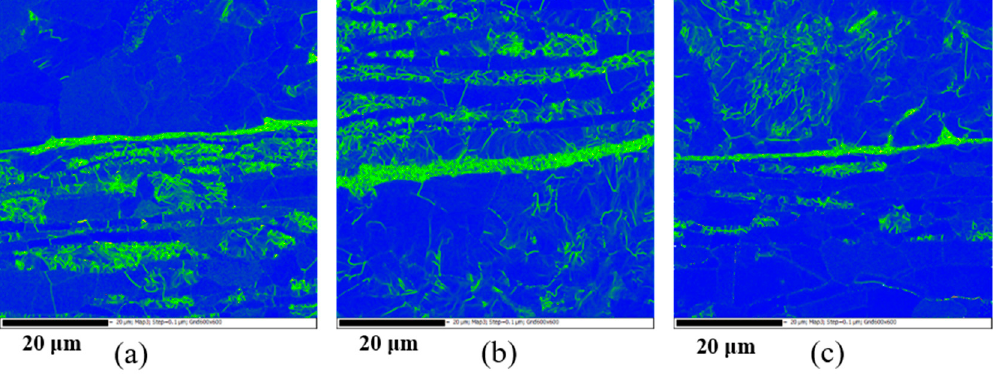
Figure 14. Images of geometrically necessary dislocation (GND) density mapping of specimens after hot bending: ( a ) at 950 °C with the outside 2205 steel layer, ( b ) at 950 °C with the inside 2205 steel layer and ( c ) at 1050 °C with the outside 2205 steel layer.